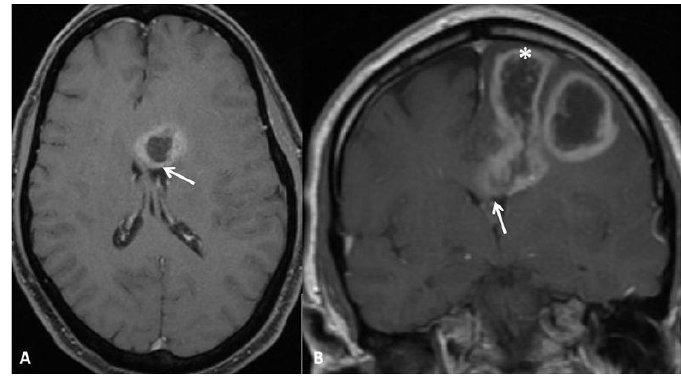
Figure 1. Evidence of Ependymal Enhancement on MRI (Group A). Axial (A) and coronal (B) gadolinium-enhanced T1-weighted images showing an enhancing tumor extending along the left frontal horn (arrow). Note cortical enhancement (asterisk, B), also present in this case.